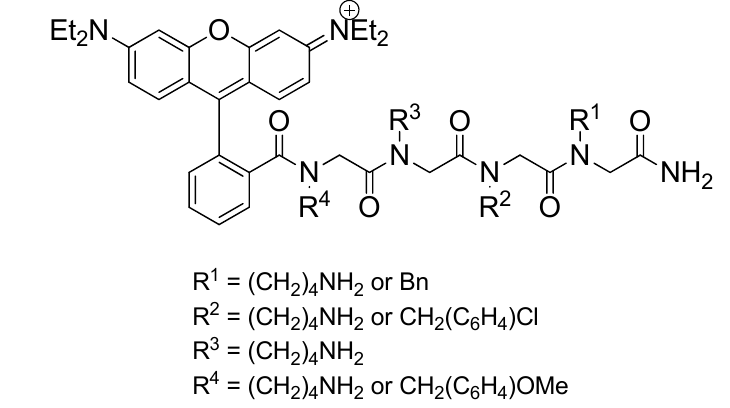
Figure 4. ( A ) General structure of the rhodamine B-labeled tetrameric peptoid library. ( B ) Schematic view of the library members. +, cationic Nlys residues; spheres are representing the peptoid